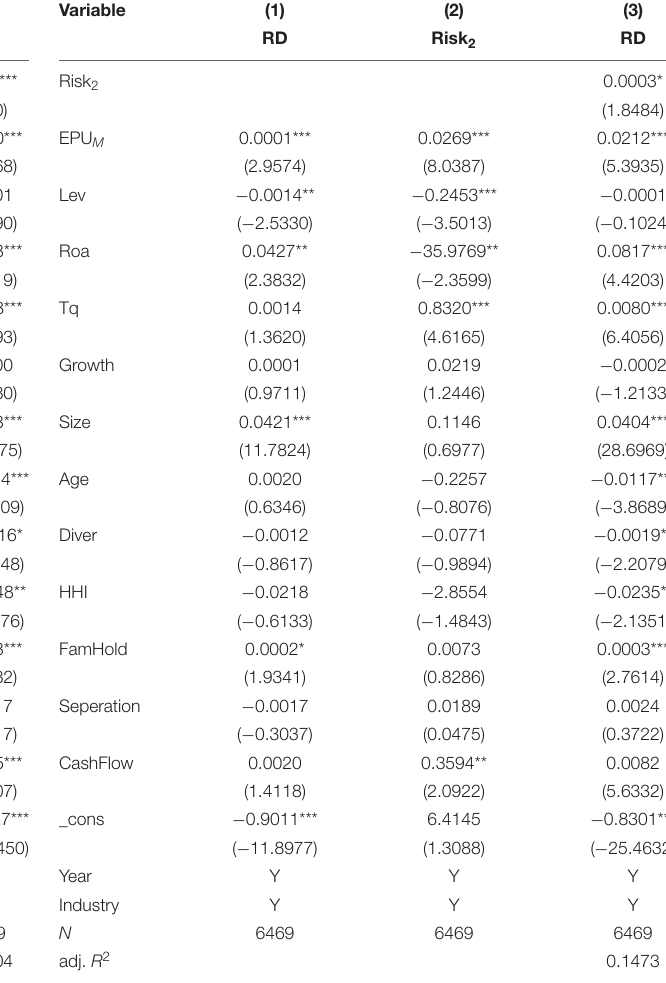
TABLE 7–2(1) | Risk-taking. TABLE 7–2(2) |